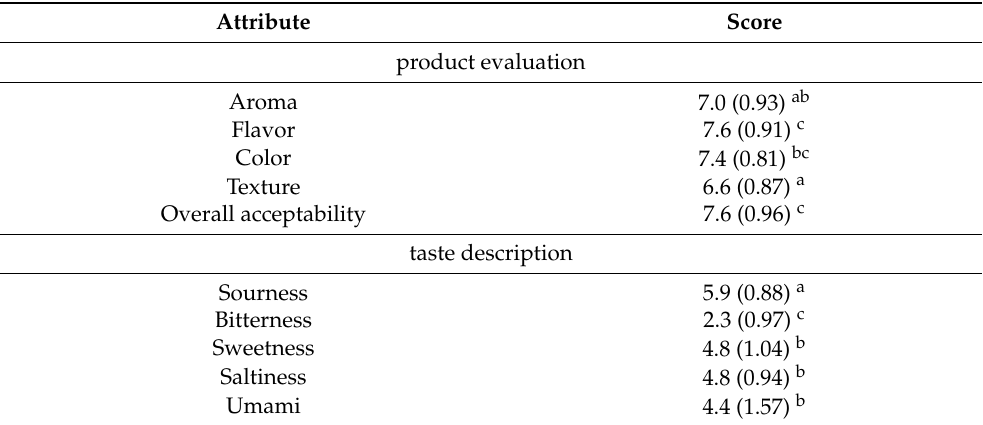
Table 2. Sensory evaluation of spontaneously fermented